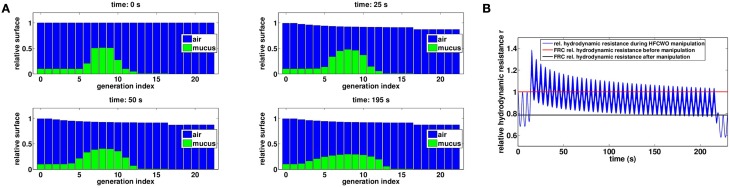
(A) Evolution of mucus distribution in the bronchi during the manipulation with Ps = 5.6 cmH2O and Po = 1.2 cmH2O. (B) Relative hydrodynamic resistance changes during a manipulation with Pcp = 20 cmH2O (blue). The red line corresponds to FRC relative hydrodynamic resistance before the manipulation (r|t = 0s = 1.00) while the black line corresponds to FRC relative hydrodynamic resistance at the end of the manipulation (r|t = 230s = 0.79).